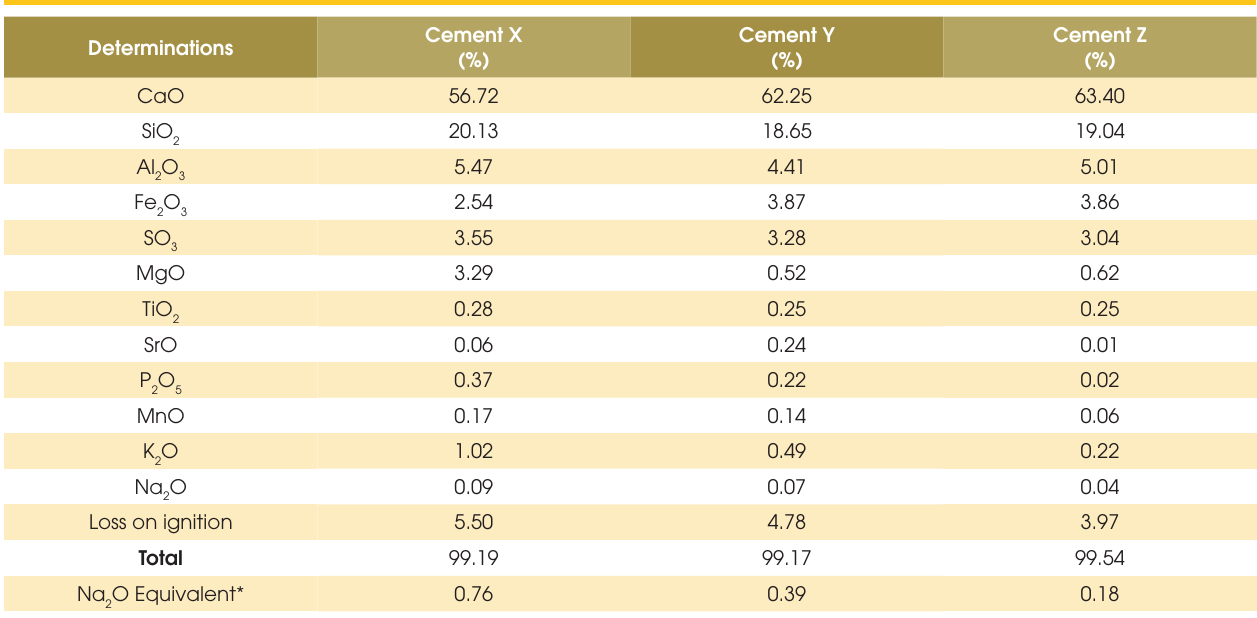
Table 8 – Chemical composition of the cements X, Y e